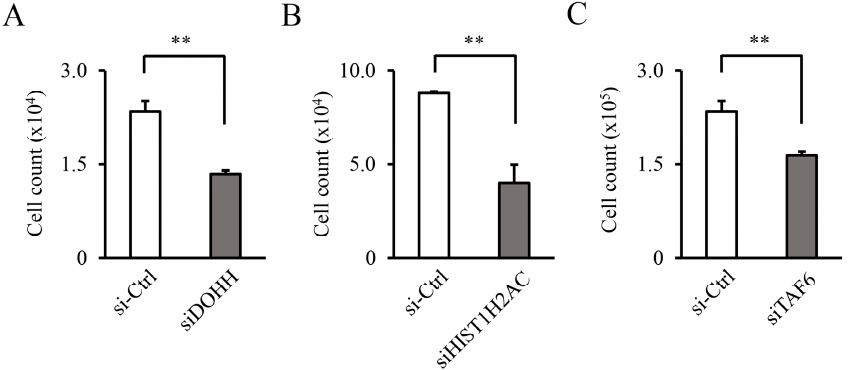
Figure 6. Knockdowns of DOHH , HIST1H2AC , and TAF6 by siRNA inhibit cell proliferation. The THP-1 parental cell lines were transfected with siRNAs and the number of viable cells were counted after 48 h. ( A ) DOHH , ( B ) HIST1H2AC , and ( C ) TAF6 were targeted and Silencer Select Negative Control No. 1 siRNA (si-Ctrl) was used as a negative control. Data are expressed as mean ± SD. Statistical significance was determined using an unpaired t -test. ** p < 0.01.